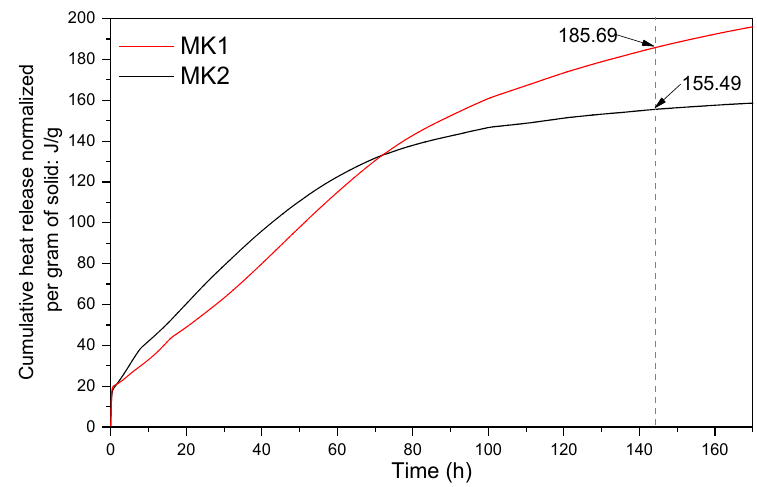
Figure 4. R 3 test of MK1 and MK2 to assess the reactivity of precursors.